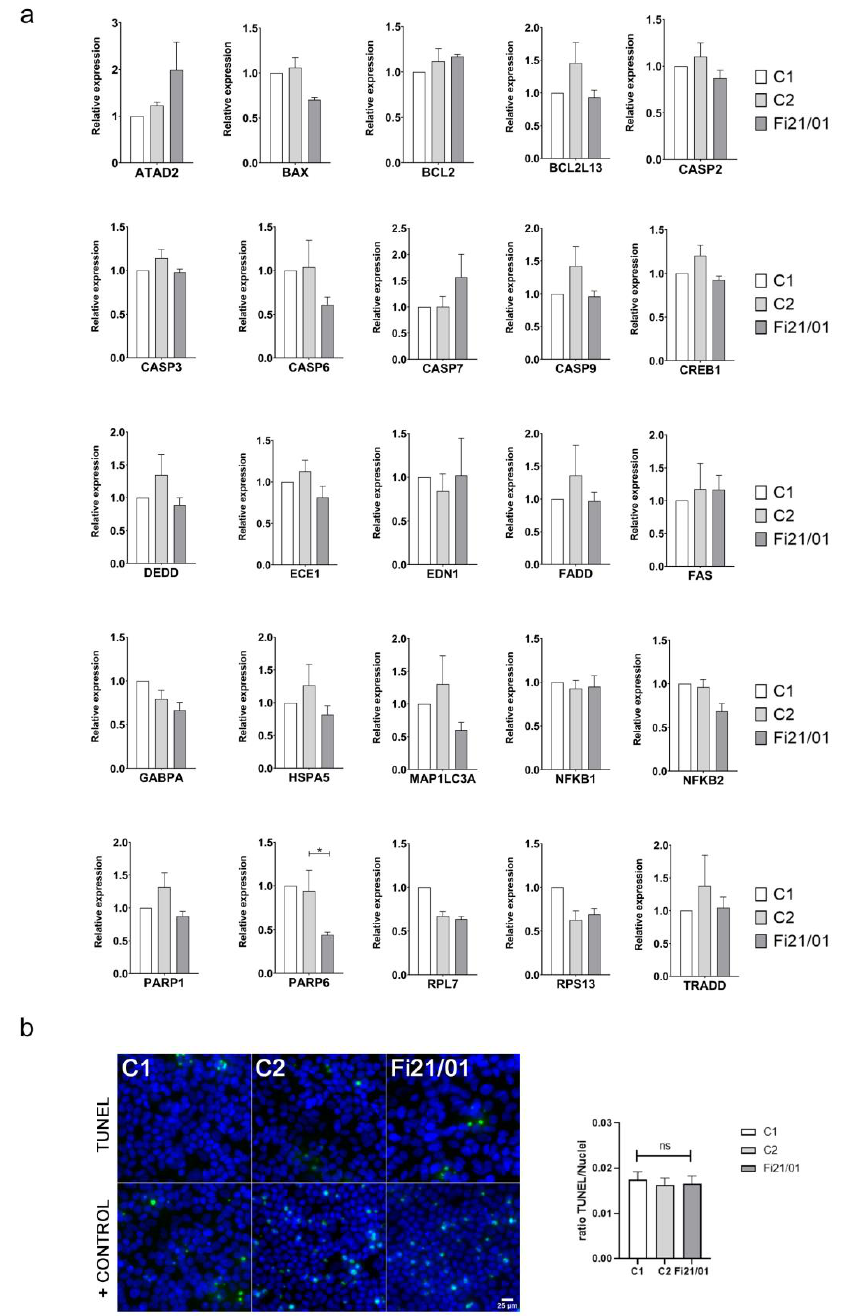
Figure 4. Apoptotic profile on iPSC-RPE cells. ( a ) Relative gene expression of a panel of 25 genes associated with cell apoptosis on both control and Fi21/01 iPSC-RPE. All experiments were performed in triplicates and at least three times with GAPDH , 18S , HPRT1, and GUSB as housekeeping control genes. ( b ) TUNEL assay of C1, C2, and Fi21/01 iPSC-RPE showing the ratio of TUNEL spots to cell nuclei. All experiments were performed at least three times from different biological replicates. Significance was determined by One-way ANOVA (* = p < 0.05, ns = non-significant). Scale bar: 25 µm.